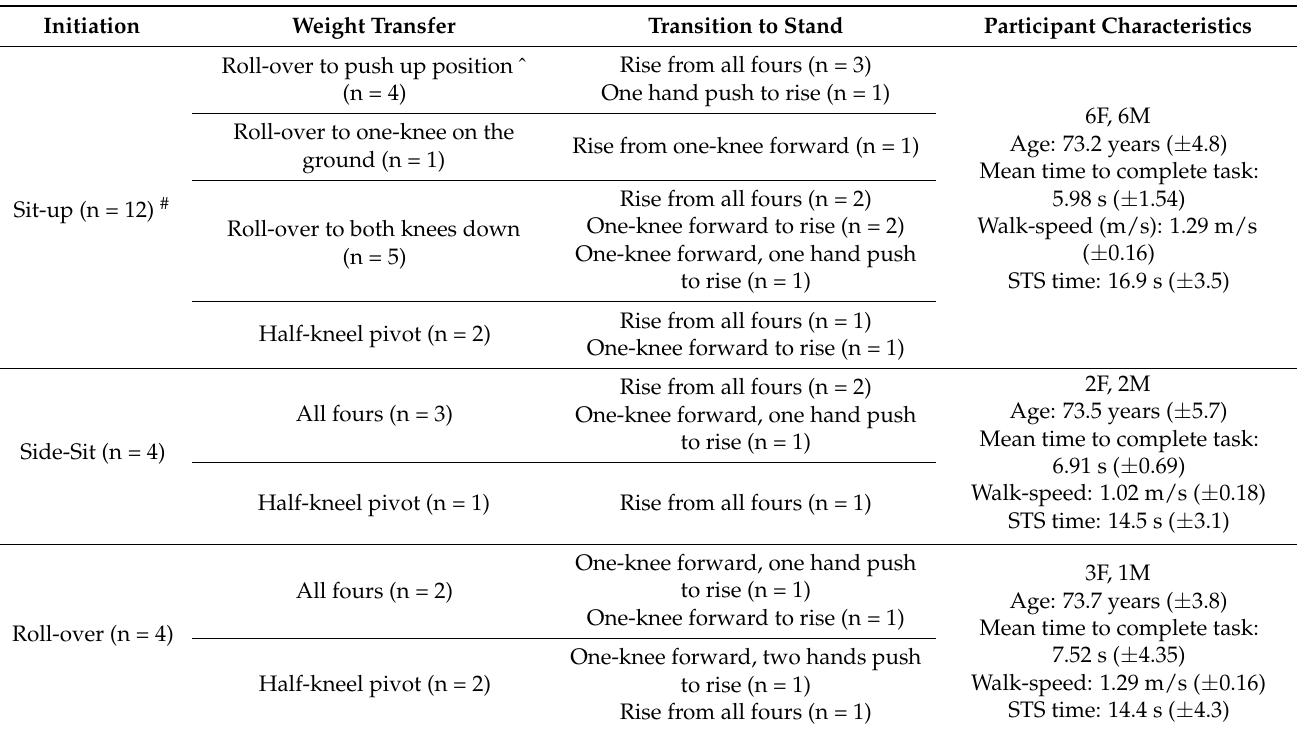
Table 2. Movement strategies demonstrated by participants from the Floor-to-Stand tasks, categorized by three